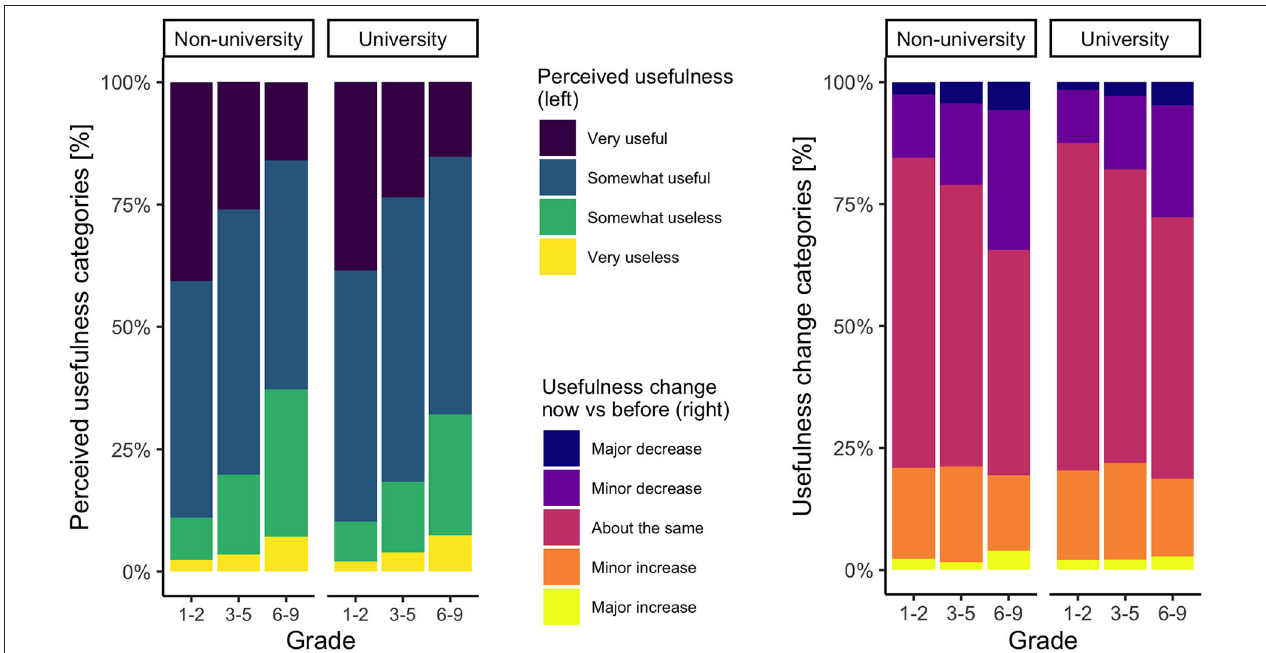
FIGURE 2 | The perception of usefulness of current schoolwork (Q9 and Q10 from the survey). (Left) Actual answers by parents. (Right) Change in perceived usefulness: homework before the COVID-19 lockdown vs. current schoolwork. Decrease means that the perceived usefulness is currently lower. Breakdown based on the child’s grade and the parents’ highest level education